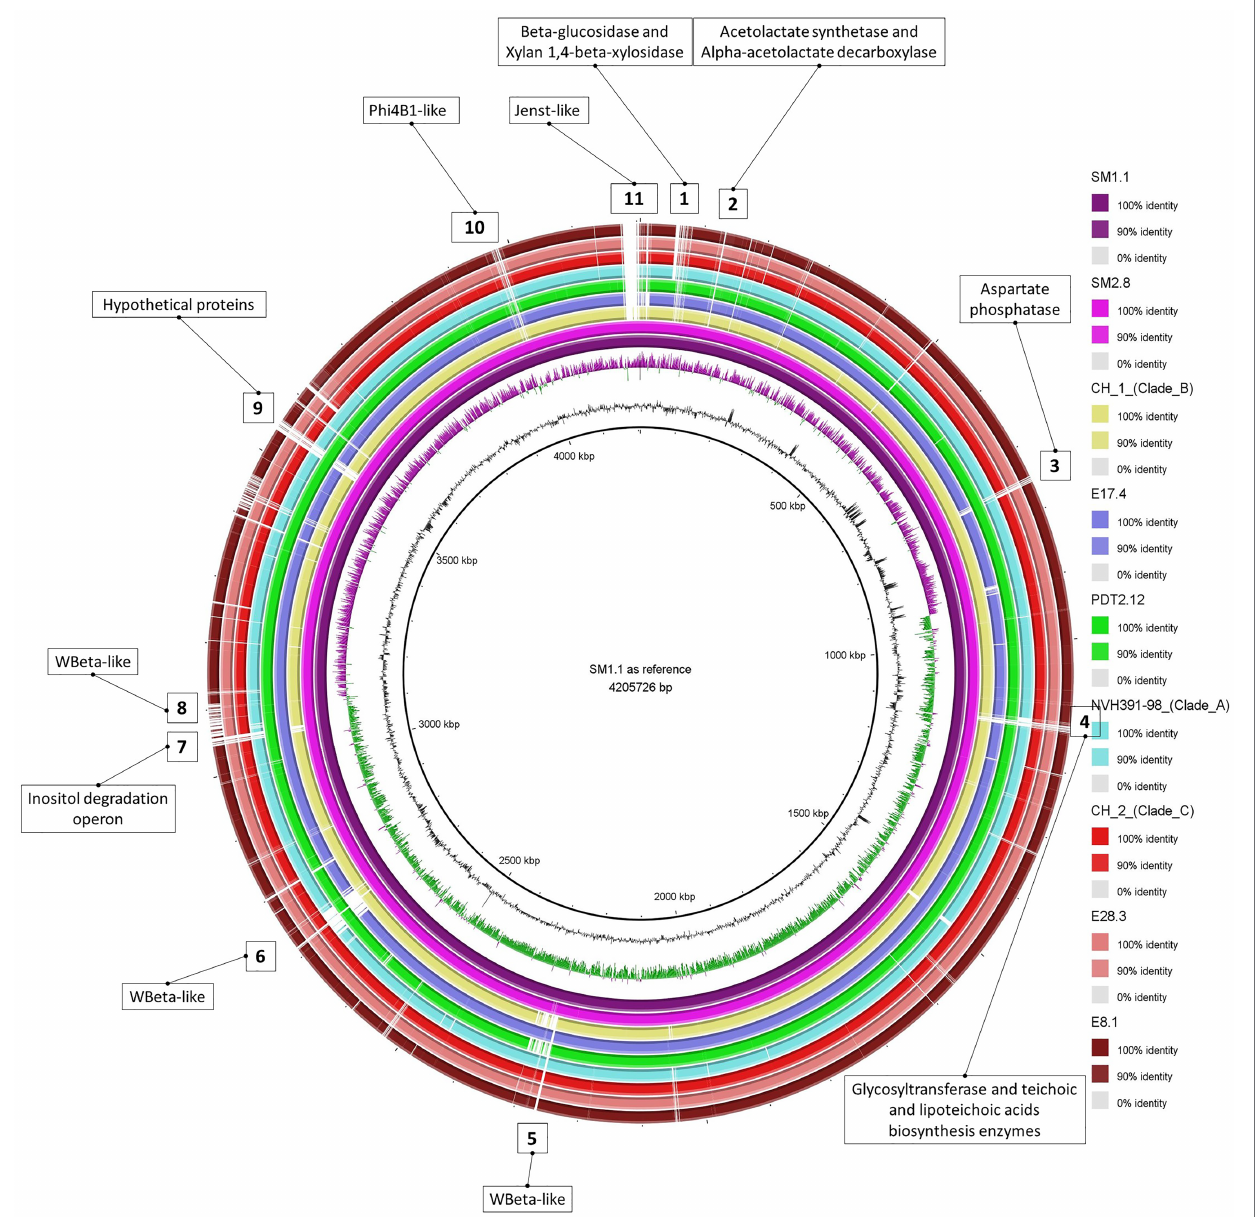
FIGURE 1 | Comparison of nine B. cytotoxicus chromosomal sequences. From the center to the periphery: SM1-1 (used as reference), SM2-8, CH_1 (clade B), E17.4, PDT12.12, NVH 391-98 (Clade A), CH_2 (Clade C), E28.3, and E8.1. The white trips represent the indels found in the reference, strain SM1.1, but absent in corresponding strains. Eleven relevant indels are highlighted and